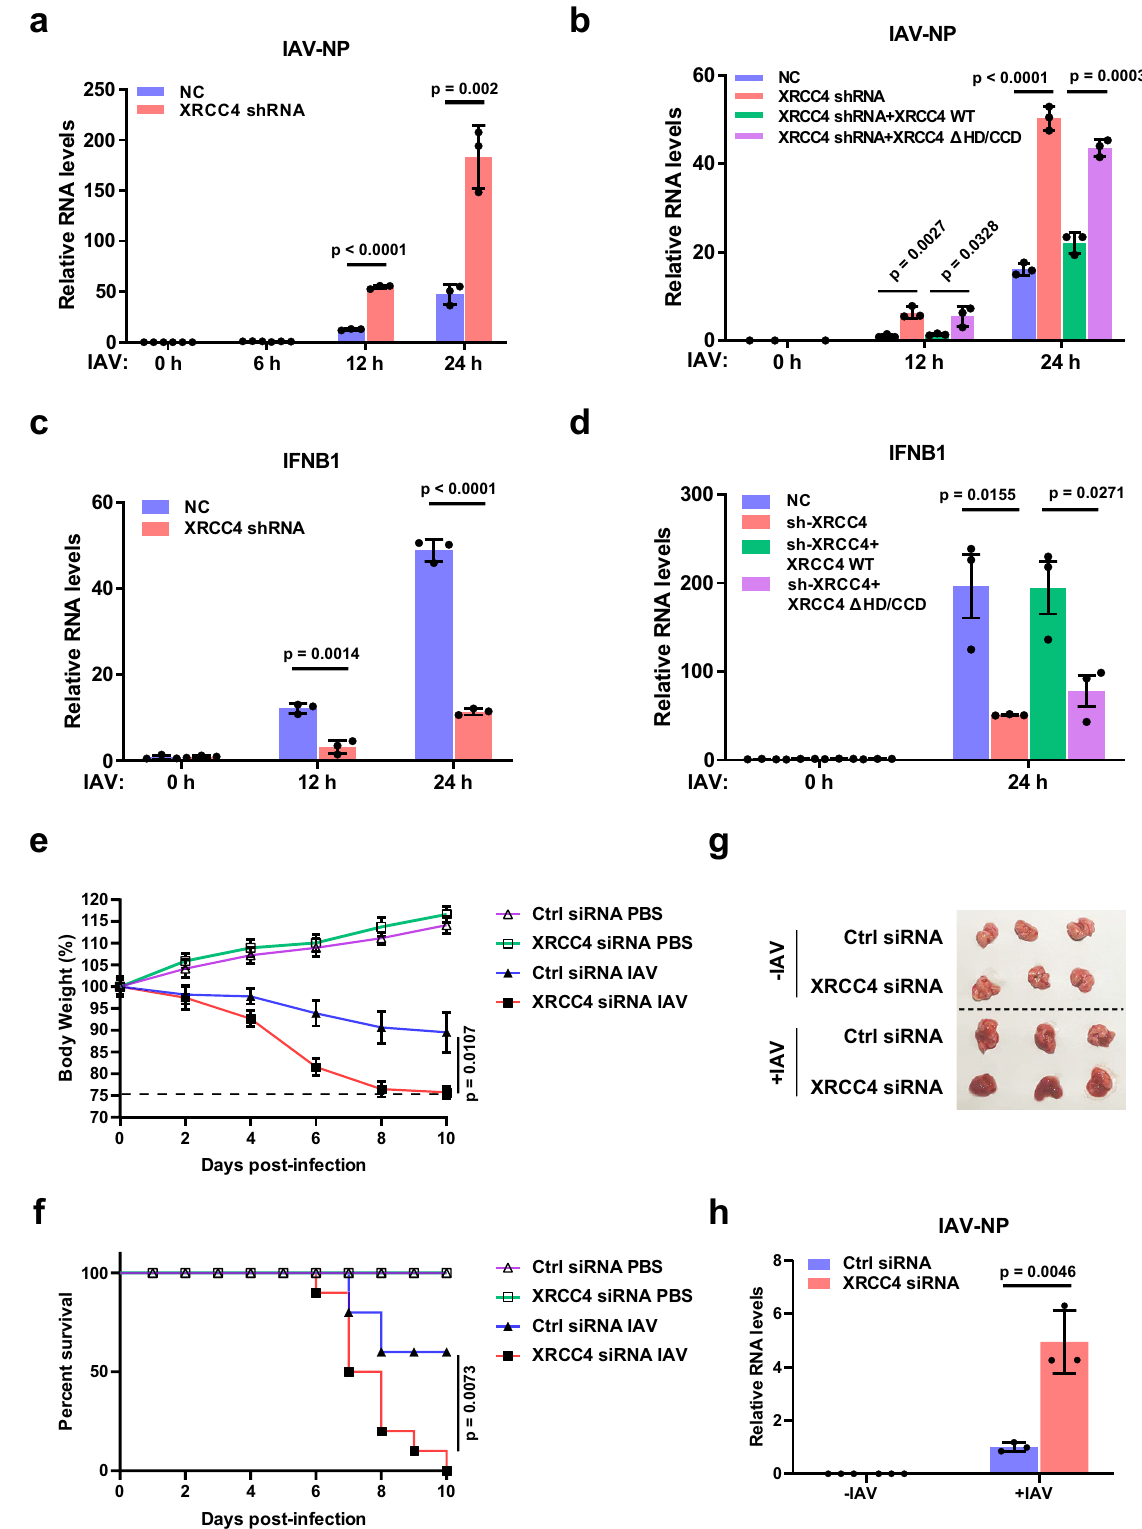
protocol. Brie fl y, The ER-AsiSI U2OS cells were treated with 4-hydroxytamoxifen (4-OHT; Sigma-Aldrich) to induce DSBs 27 . Next, cells were cross-linked with 1% formaldehyde and neutralized with 125-mM glycine. The cross-linked nuclear lysates were digested with micrococcal nuclease, and then sonicated to yield genomic DNA fragments between 150 and 900 bp. The digested chromatin was immunoprecipitated with the indicated primary antibody overnight at 4°C. The immunocomplexes were pulled down with magnetic beads, reversely